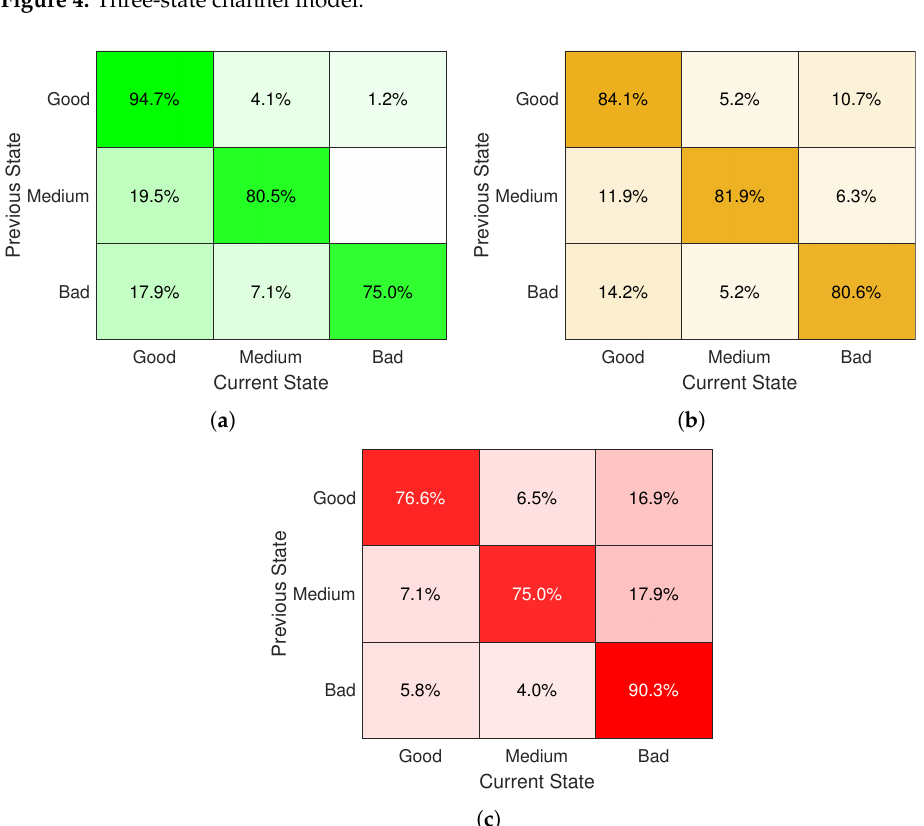
Figure 4. Three-state channel model.